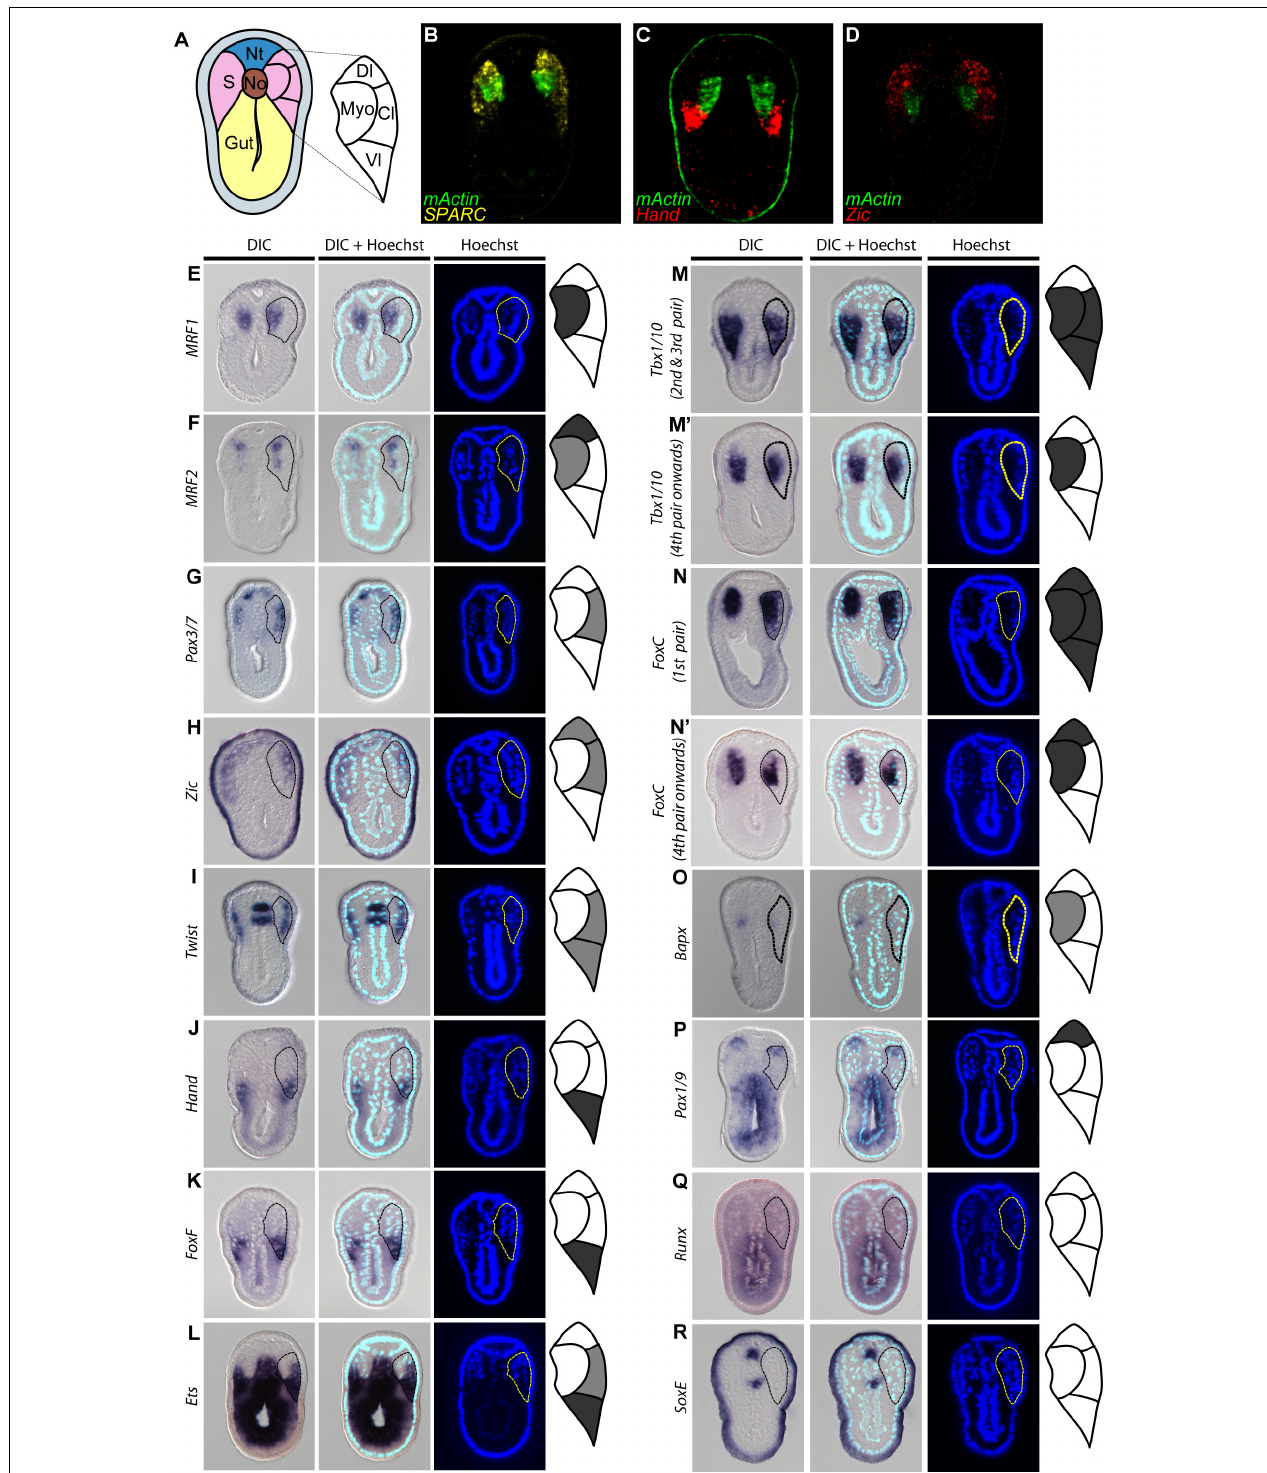
FIGURE 4 | Comparable compartments inside the amphioxus somite can be recognized by the expression of specific marker genes. (A) Schematic drawing of an N3 stage (six somite) embryo cross section. The somite region (pink) can be compartmentalized into four regions based on the expression of different marker genes. Myo, myotome; Dl, dorsolateral; Cl, Centrolateral; Vl, ventrolateral; Nt, neural tube; S, somite; No, Notochord. (B–D) Double fluorescent in situ hybridization of sectioned embryos. (E–R) Expression pattern of known somite marker genes in N3 stage embryos, taken from around 5th somite level. In the schematic diagrams, dark gray represents stronger expression while light gray represents weaker expression. The right somite is outlined with dashed lines. (Q,R) Expression patterns of known vertebrate sclerotome marker genes that are not expressed in the amphioxus somites. The right somite is outlined with dashed-lines.